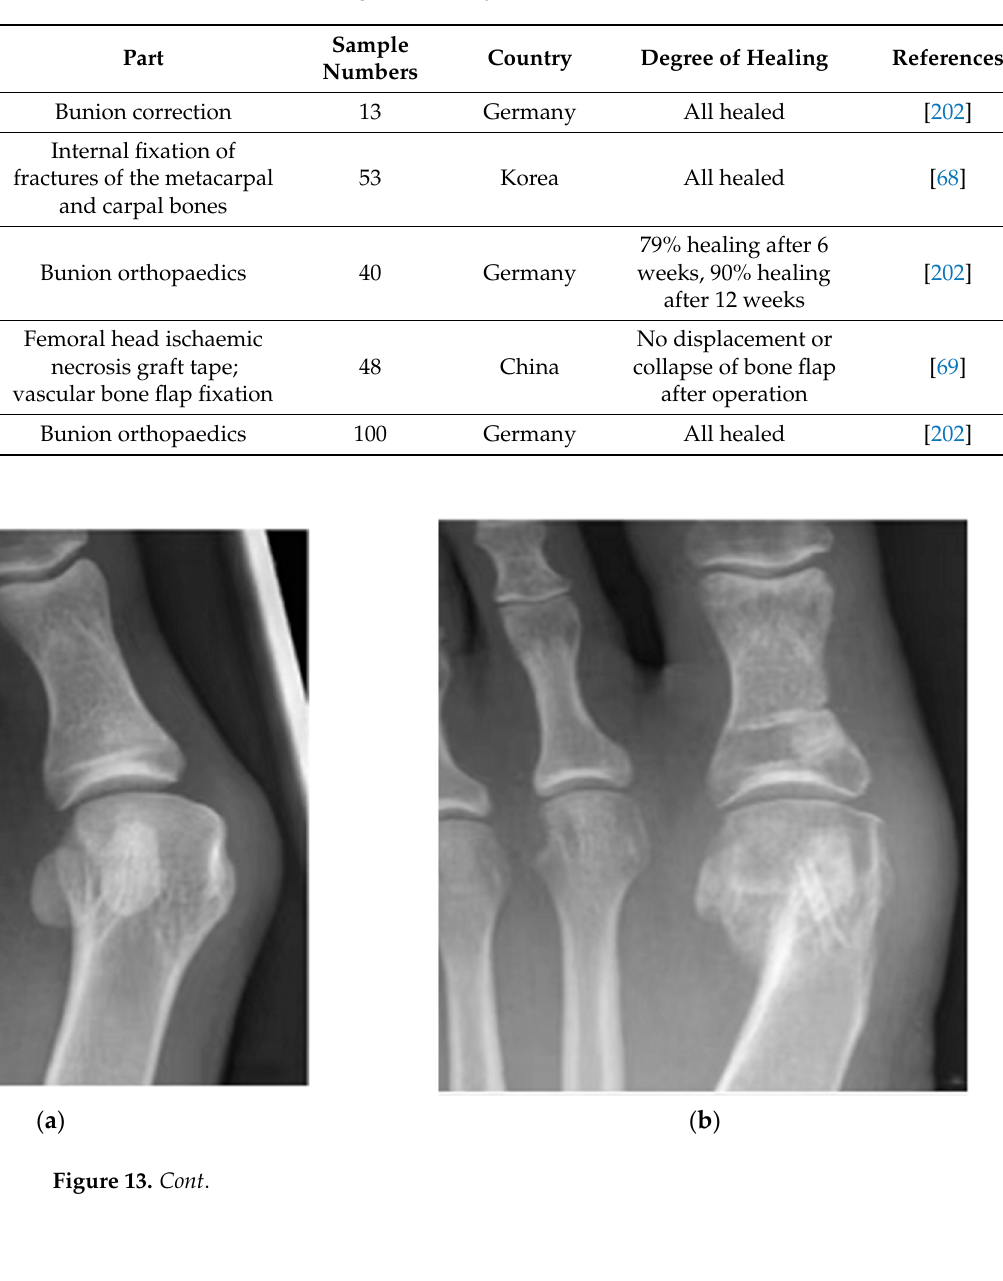
Table 4. Clinical trials with magnesium alloys.